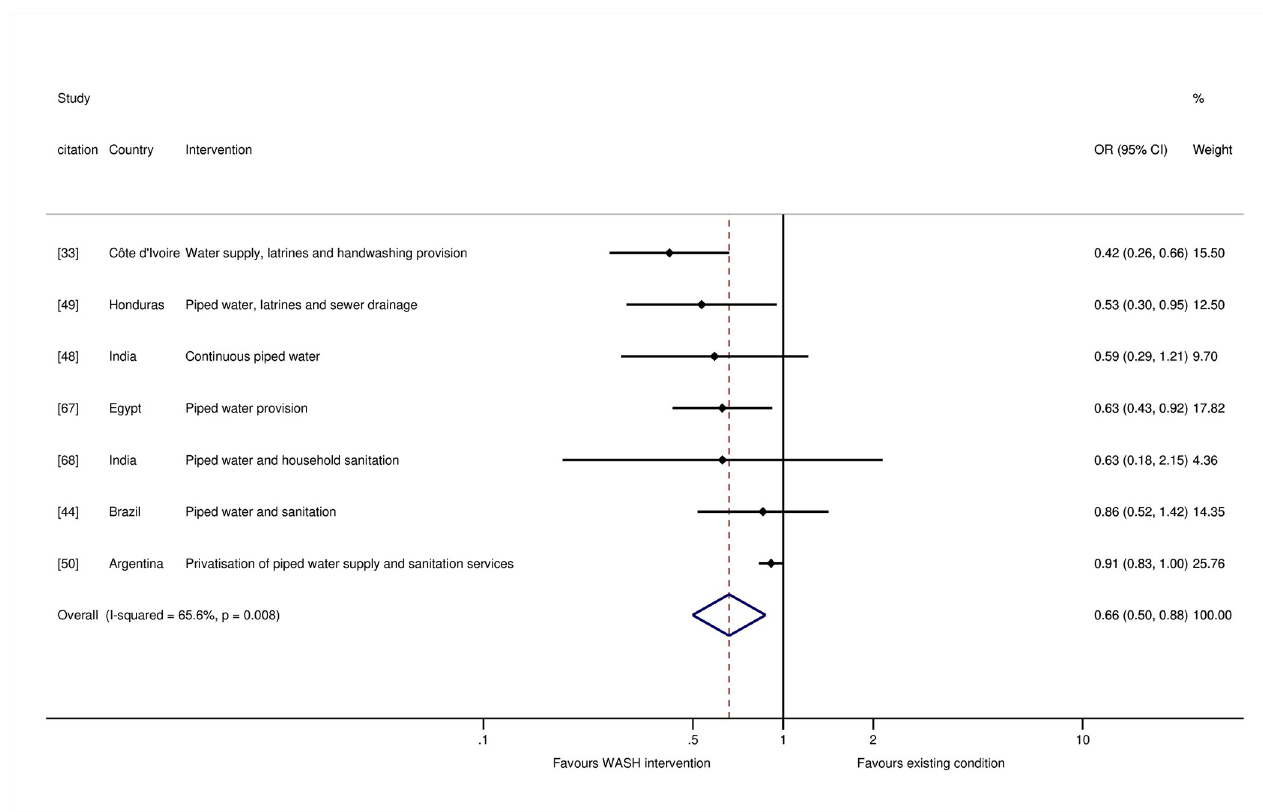
Fig 5. Effects on all-cause mortality in childhood of water supply